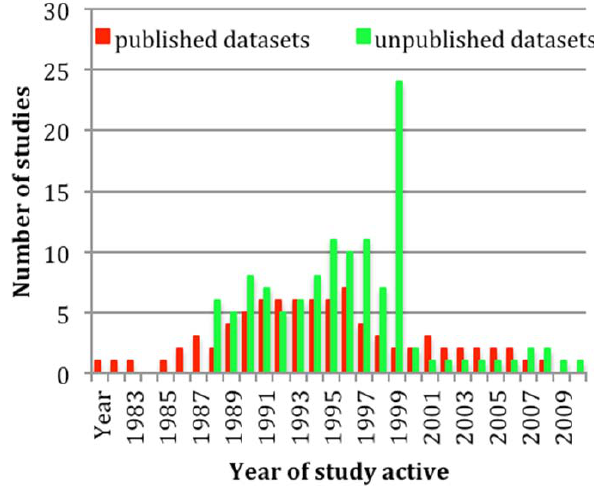
Figure 5 Active data sets active in study years.